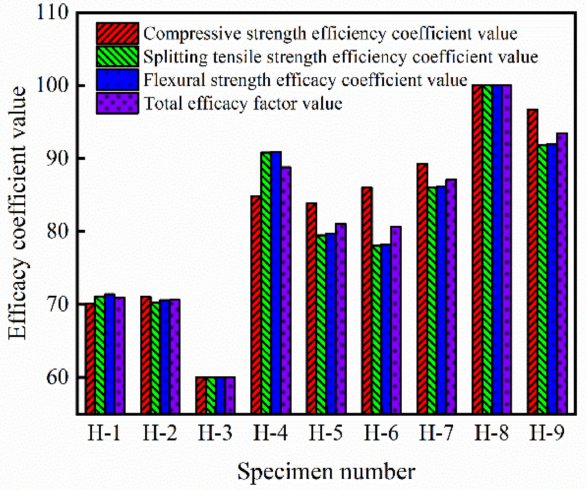
Figure 5. The efficiency coefficient value of